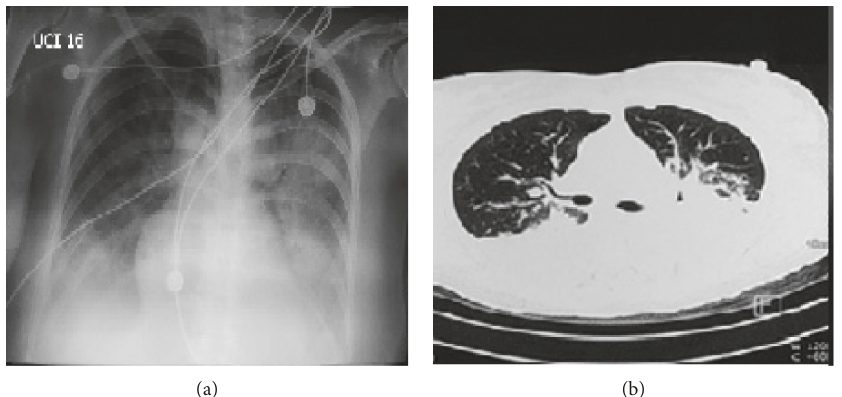
Figure 1: (a) Chest X-ray; AP view: bilateral, diffuse basal and perihilar alveolar infiltrate; (b) chest CT: bilateral effusion, increased vascularity, with bilateral infiltrates that converges to the posterior area.